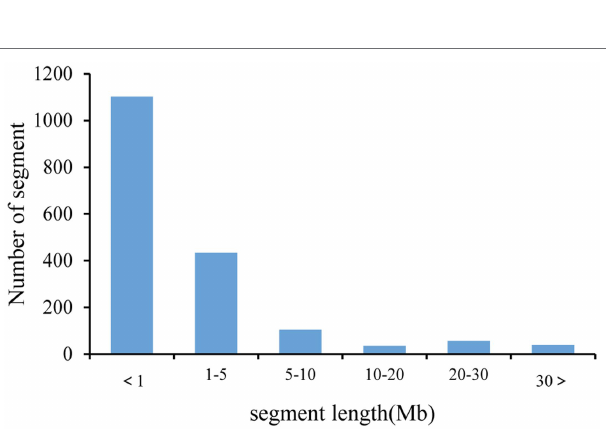
FIGURE 4 | Frequency of substituted chromosome segments according to